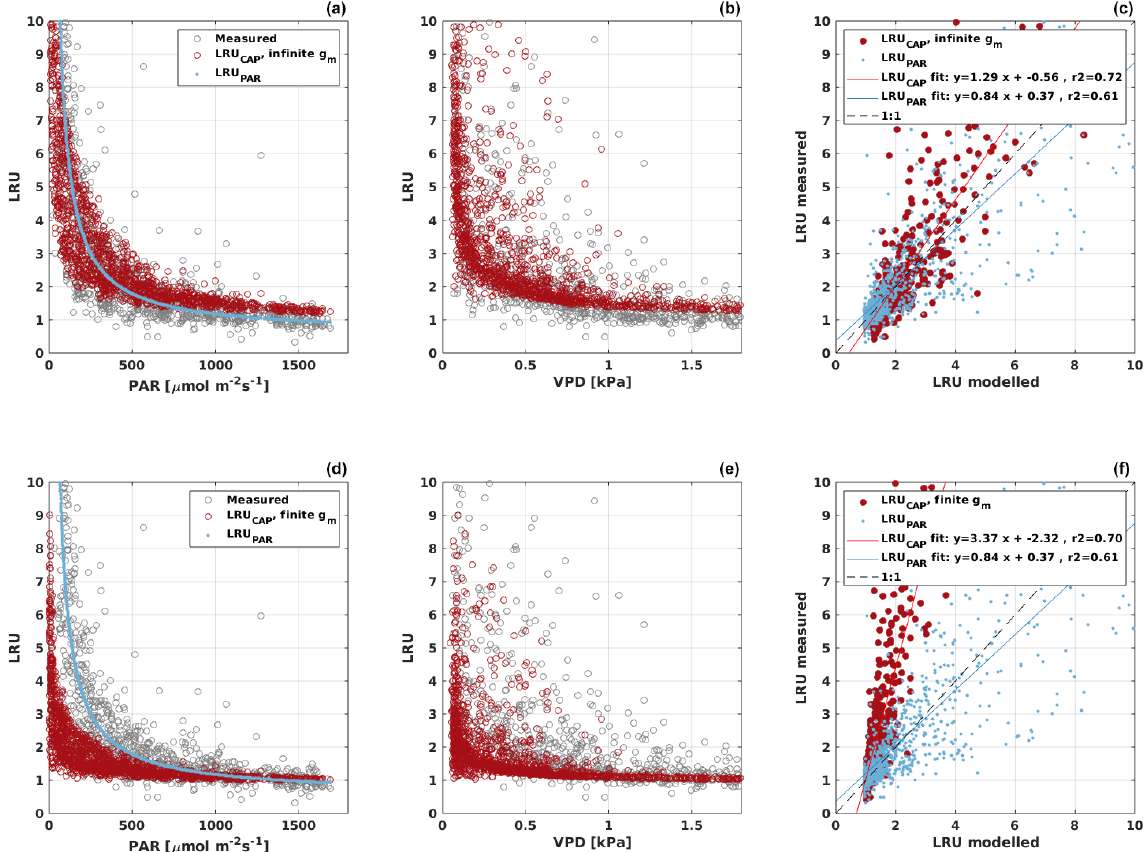
Figure B7. LRU derived from chamber measurements (gray) and modelled LRU PAR (blue) and LRU CAP (red) assuming infinite (a–c) or finite (d–f) mesophyll conductance ( g m ) in LRU CAP against PAR and VPD. Subplots (c) and (d) compare the chamber-measured LRU against modelled LRU PAR and LRU CAP